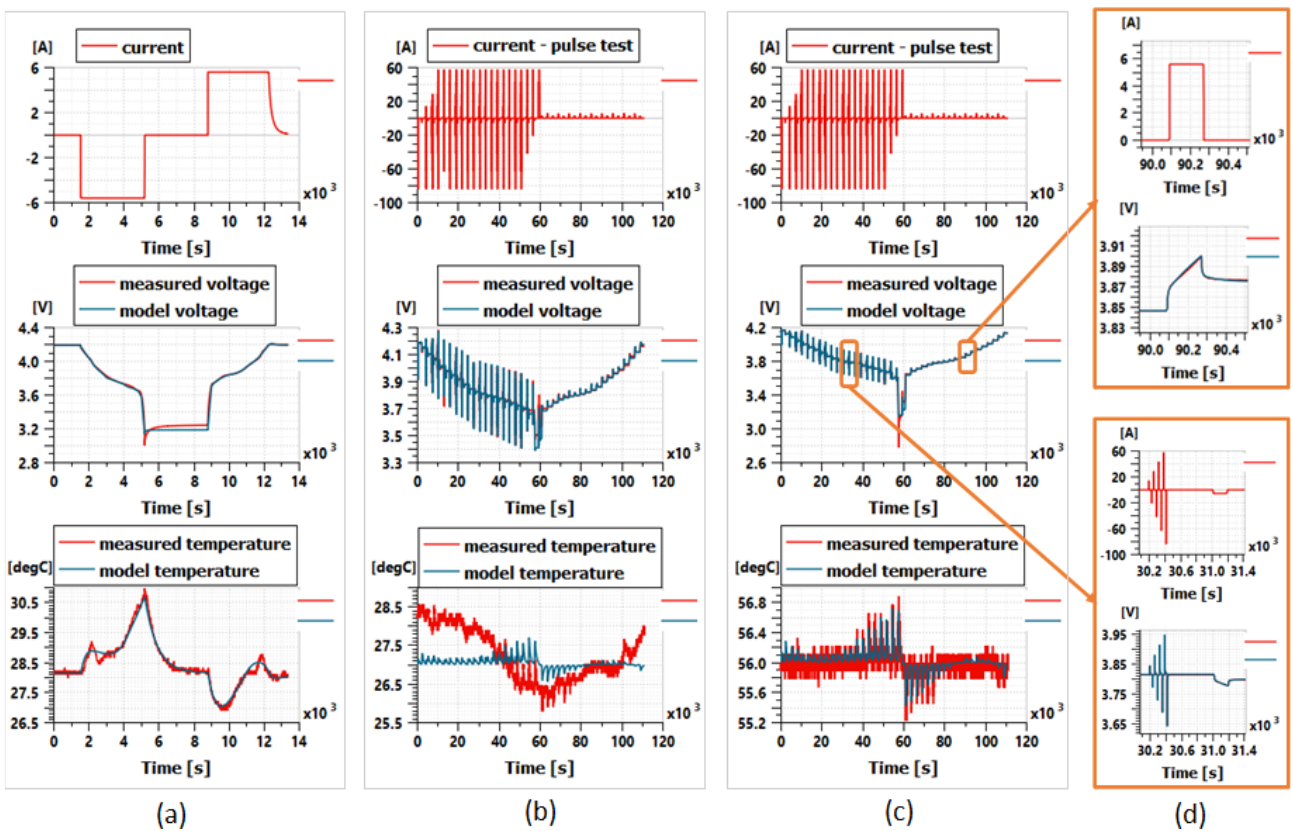
Figure 3. Experimental test data and model estimations from the Battery Electro-thermal Identifica- tion Tool in Simcenter Amesim: ( a ) constant discharge and standard CC/CV charge test; ( b ) pulse test at 25 °C; ( c ) pulse test at 55 °C; ( d ) zoom of pulse test at 55 °C.